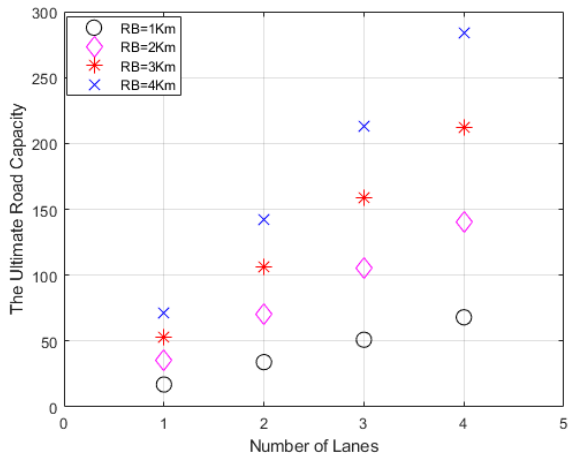
Figure 7. Ultimate road capacity.